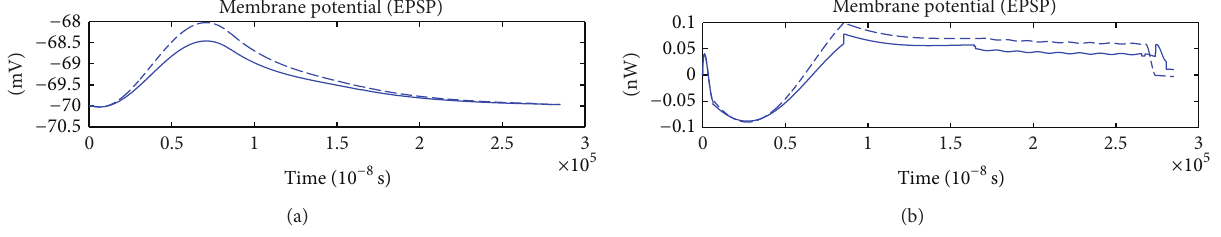
Figure 16: The EPSP and the corresponding energy function. 𝑟 0𝑚 = 0.0001 Ω , 𝑟 1𝑚 = 0.1 Ω , 𝑟 2𝑚 = 1000 Ω , 𝑟 3𝑚 = 0.1 Ω , 𝑟 𝑚 = 1000 Ω , = 1 𝜇 F, 𝐿 = 50 𝜇 H, 𝑖 = 7.155 𝜇 A, and 𝑄 = 3 × 10 −6 𝜇 A. 𝐶 𝑚 𝑚 0𝑚